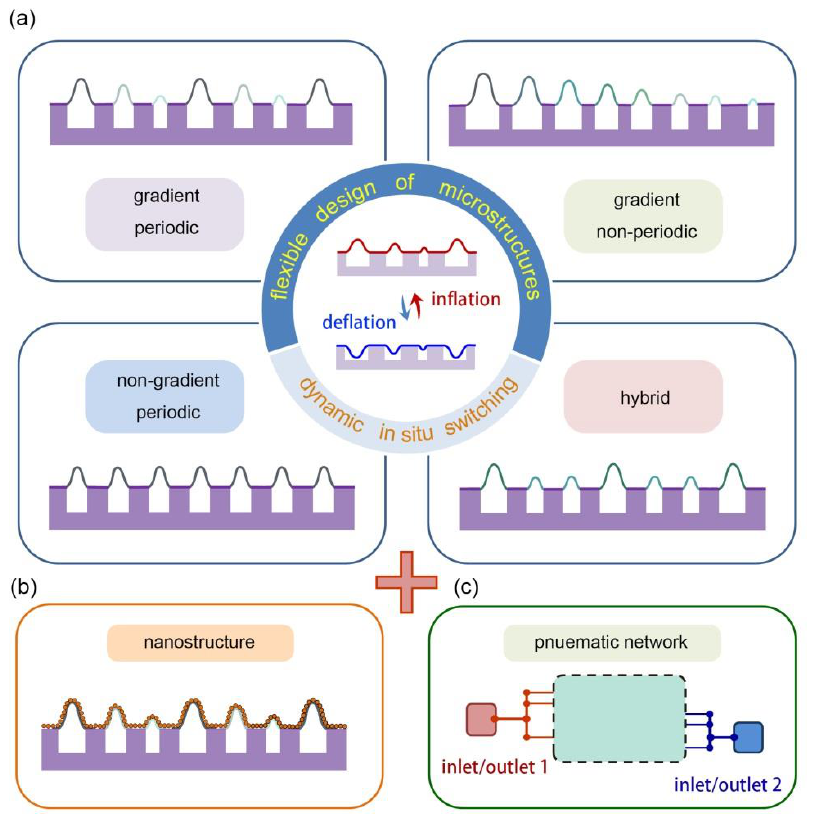
Figure 5. Outlook of the proposed technique from the aspects of ( a ) microstructure design, ( b ) nanostructure modification, and ( c ) pneumatic network